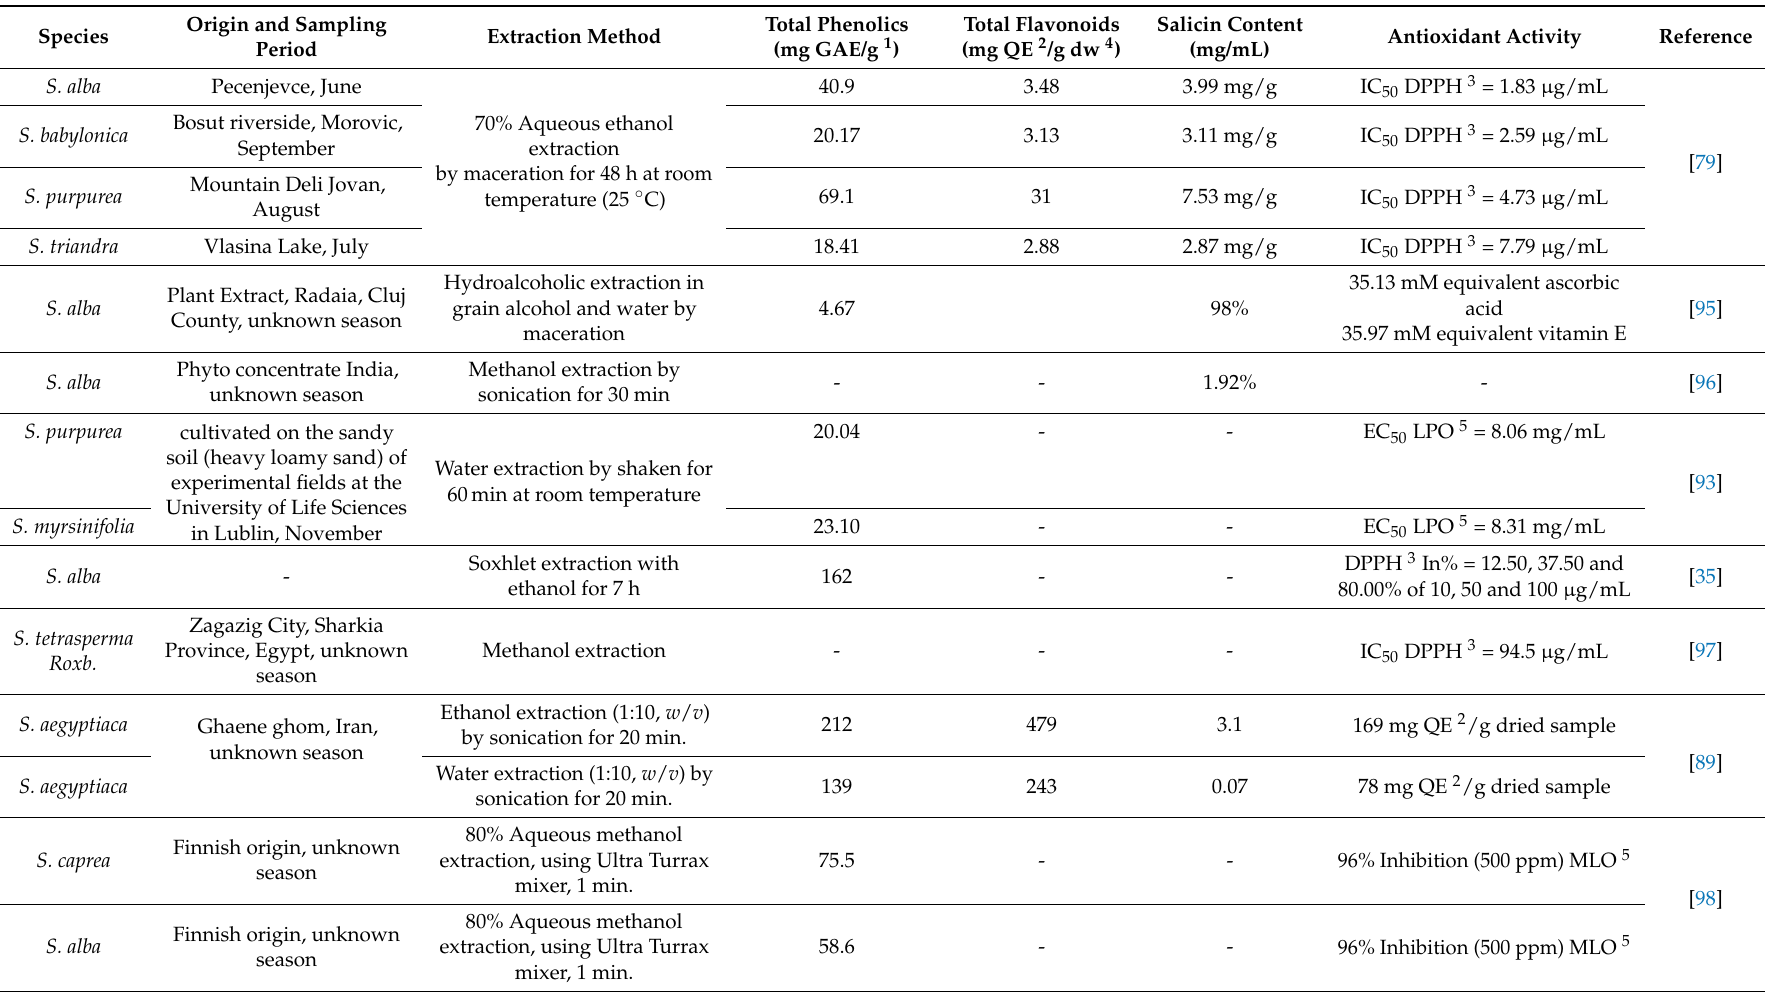
Table 2. Total phenolics content, total flavonoids content, salicin content, and antioxidant activity of different bark extracts of Salix species. Species